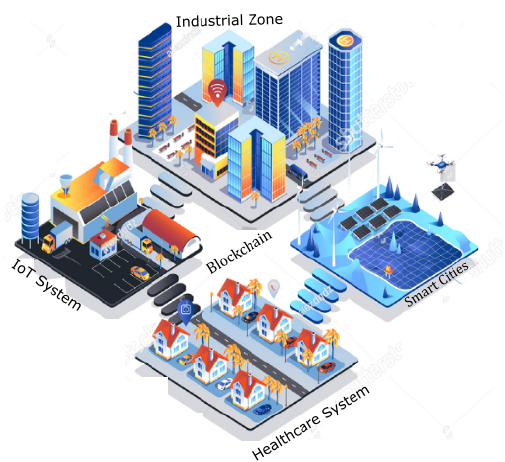
Figure 4. Applications of Blockchain in Various